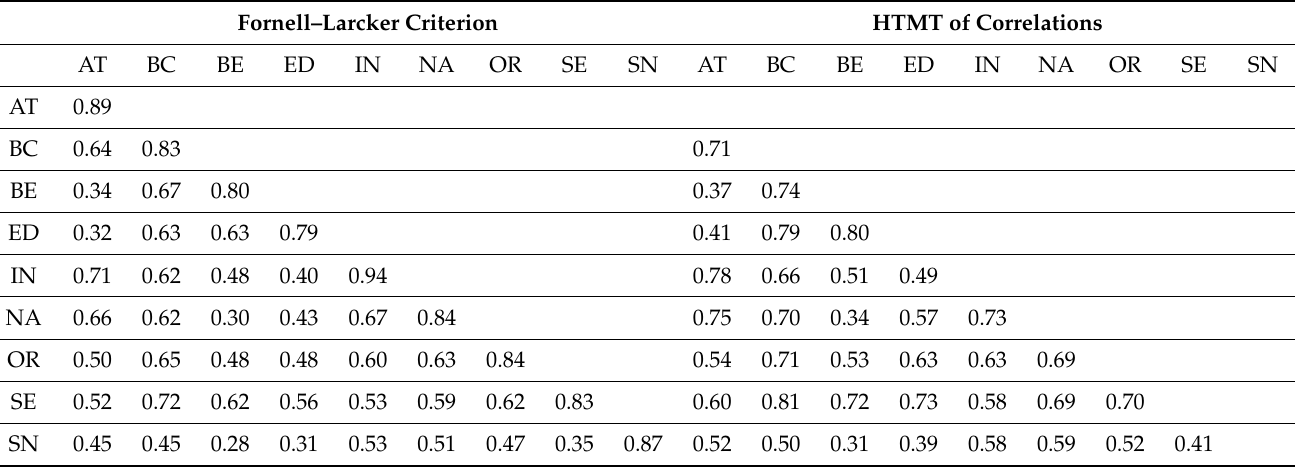
Table 2. Results of outer model’s discriminant validity assessment.